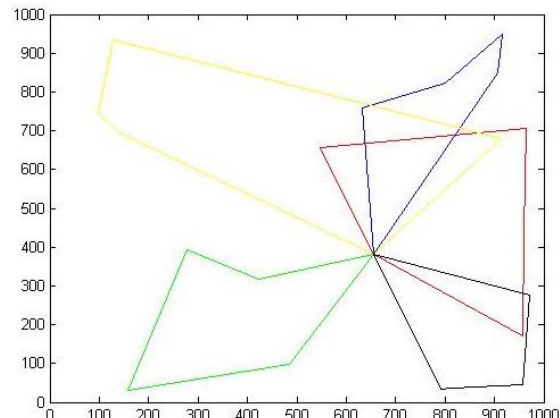
Figure 8. Scenario V, Average answer is 9735.87 m, average time is 4.08s.